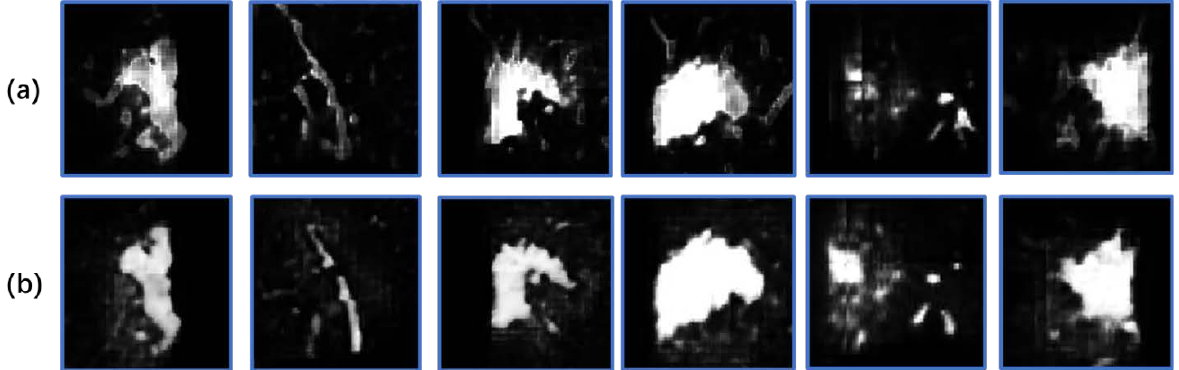
Figure 7. Map features from COVID-19 infection. ( a ) is results obtained without data enhancement. ( b ) is results obtained